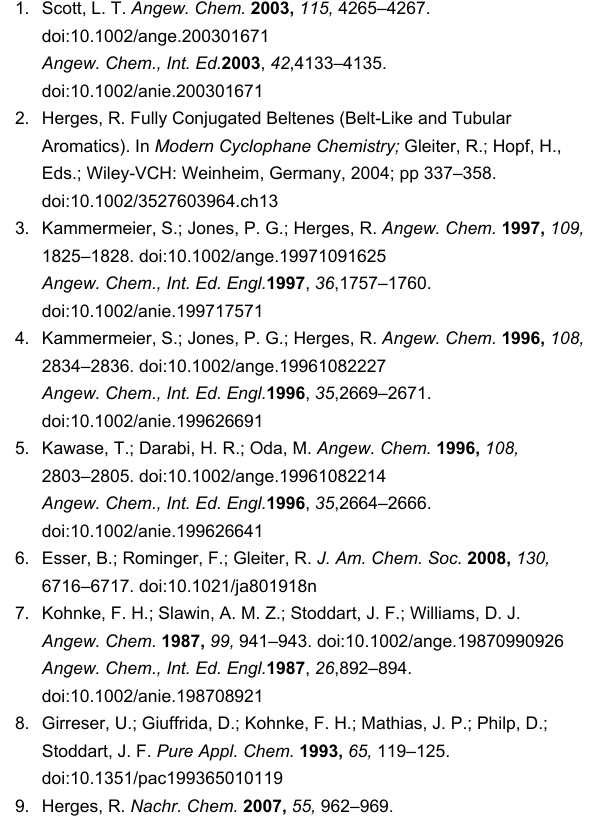
(Figure 3). The X-ray structure analysis of compound 5 confirms that of the two conceivable isomers with C 2 5a and C S symmetry 5b , the latter was formed as the main